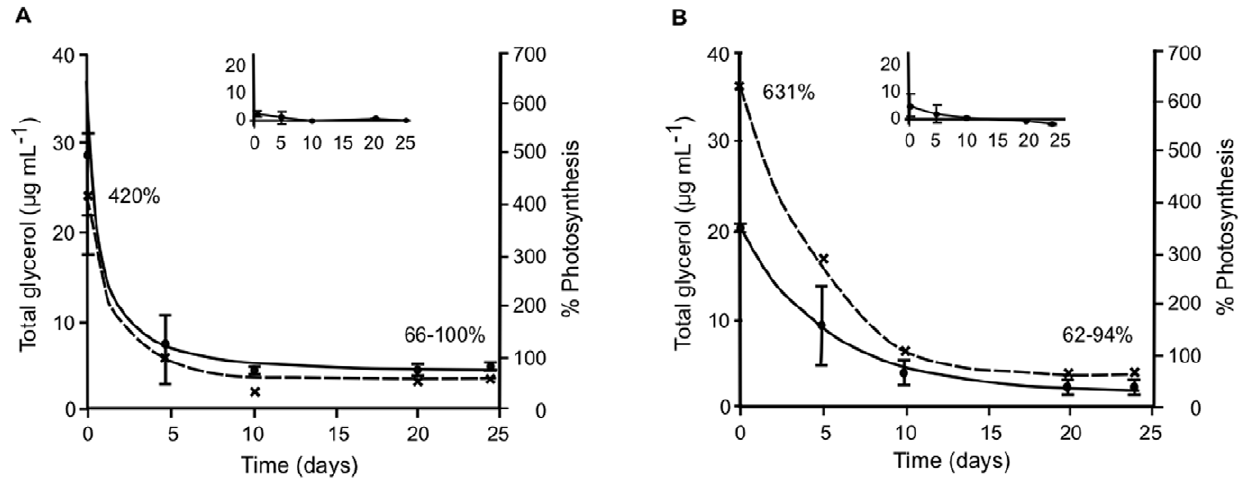
Figure 6. Percentage of photosynthesis needed to produce glycerol. Total glycerol ( m g mL 2 1 ) was measured in Symbiodinium type B17 ( A ) and type A1 ( B ) cultured in medium with 9% PEG (solid line), sampled at the indicated times. Total glycerol values for control conditions are shown as an insert. Percentage of photosynthesis (broken line) estimated using P max values (Tables 2 and 3) for the average glycerol concentration under stress at each time point. Values adjusted to 1 6 10 5 cells mL 2 1 . Mean values 6 SD (bars) from three independent